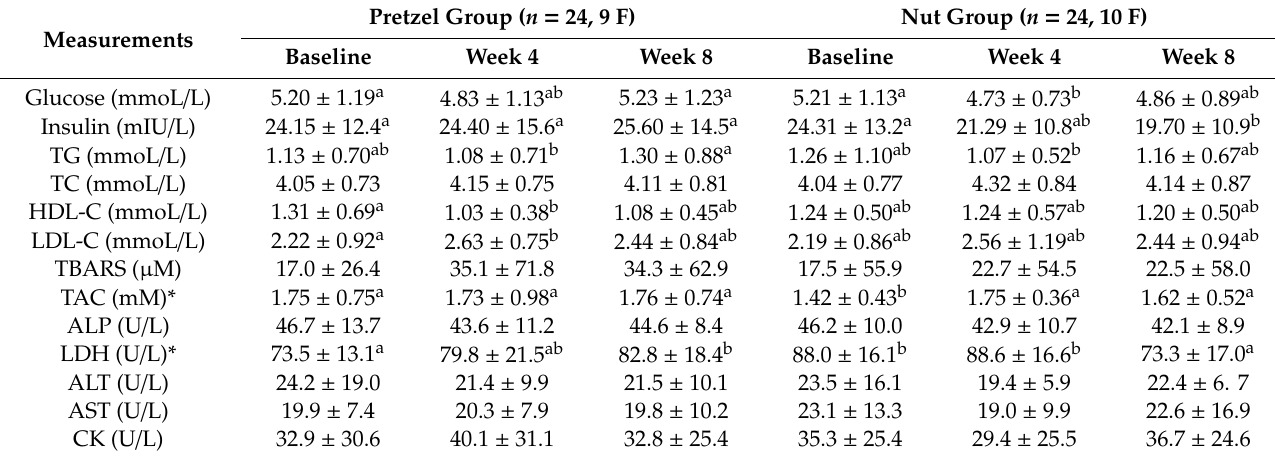
Table 3. Baseline, week 4, and week 8 biochemical measurements in the pretzel and the nut